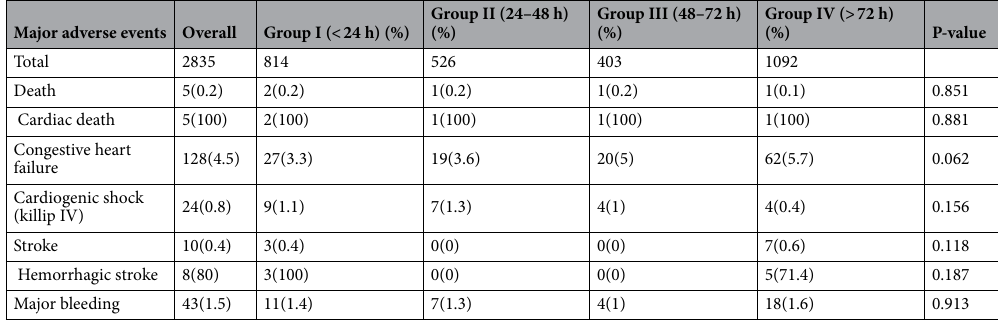
Table3. In-Hospital outcome.